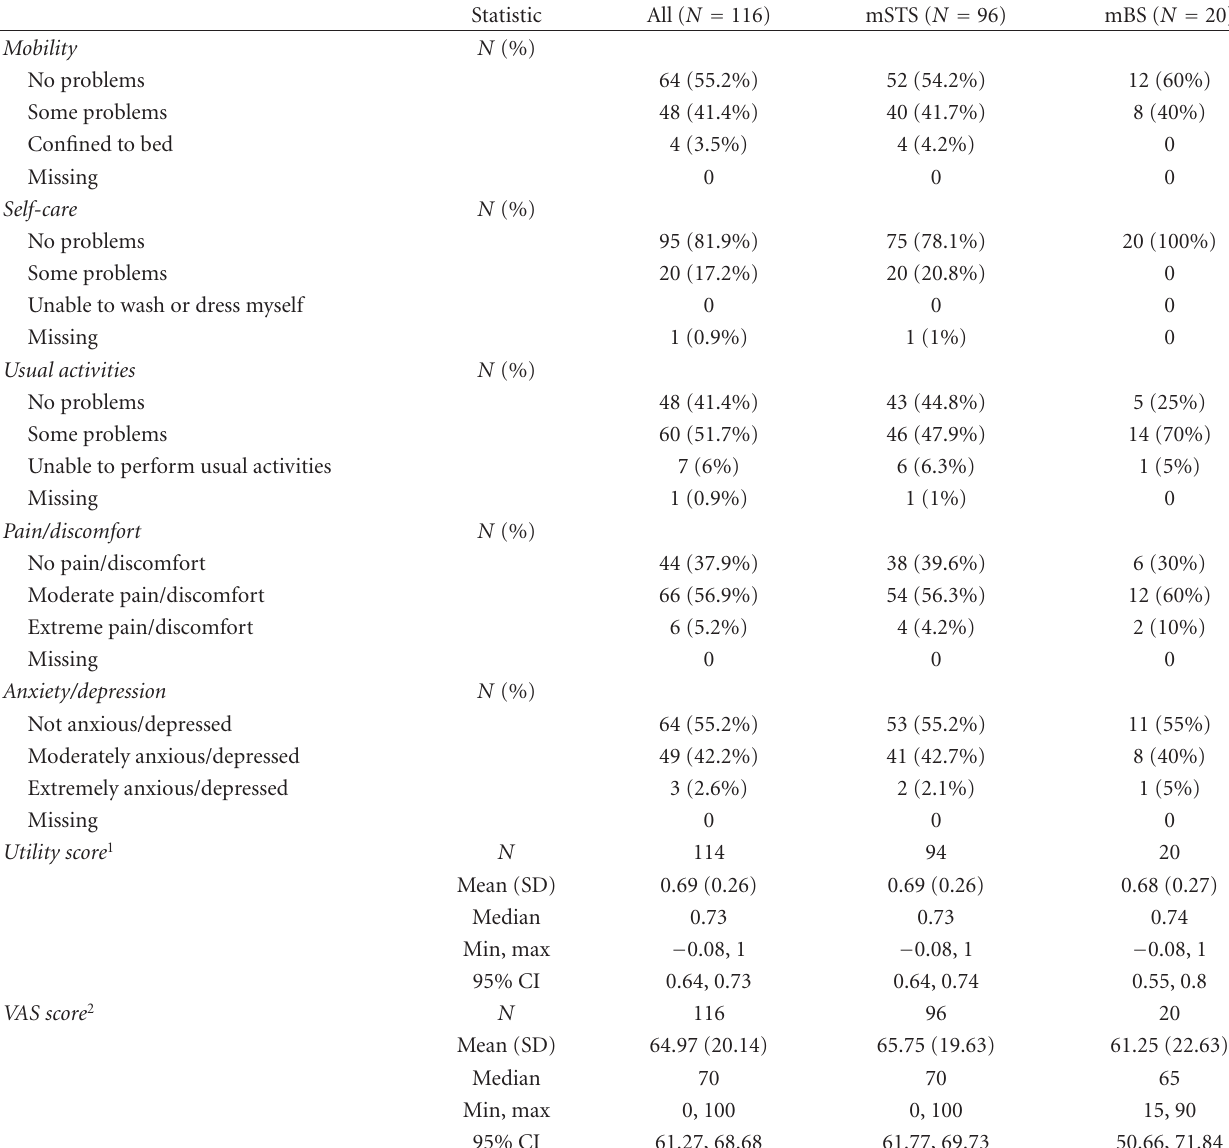
Table 3: QoL based on the